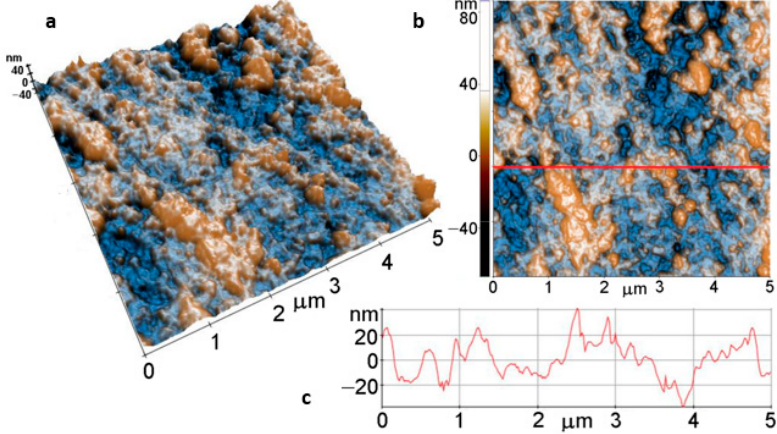
Figure 8. Tri-dimensional ( a ) and bi-dimensional ( b ) AFM images and line profile ( c) of bare